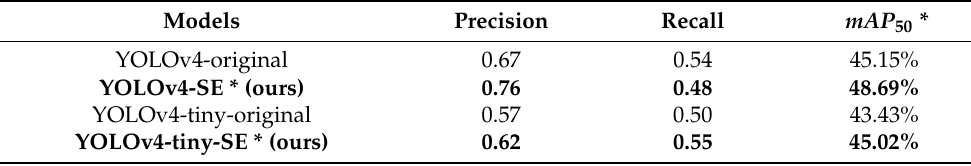
Table 5. Comparative results of the crack detection performance on the UAPD dataset. Models Precision Recall 𝒎𝑨𝑷 𝟓𝟎 * YOLOv4-original 0.67 0.54